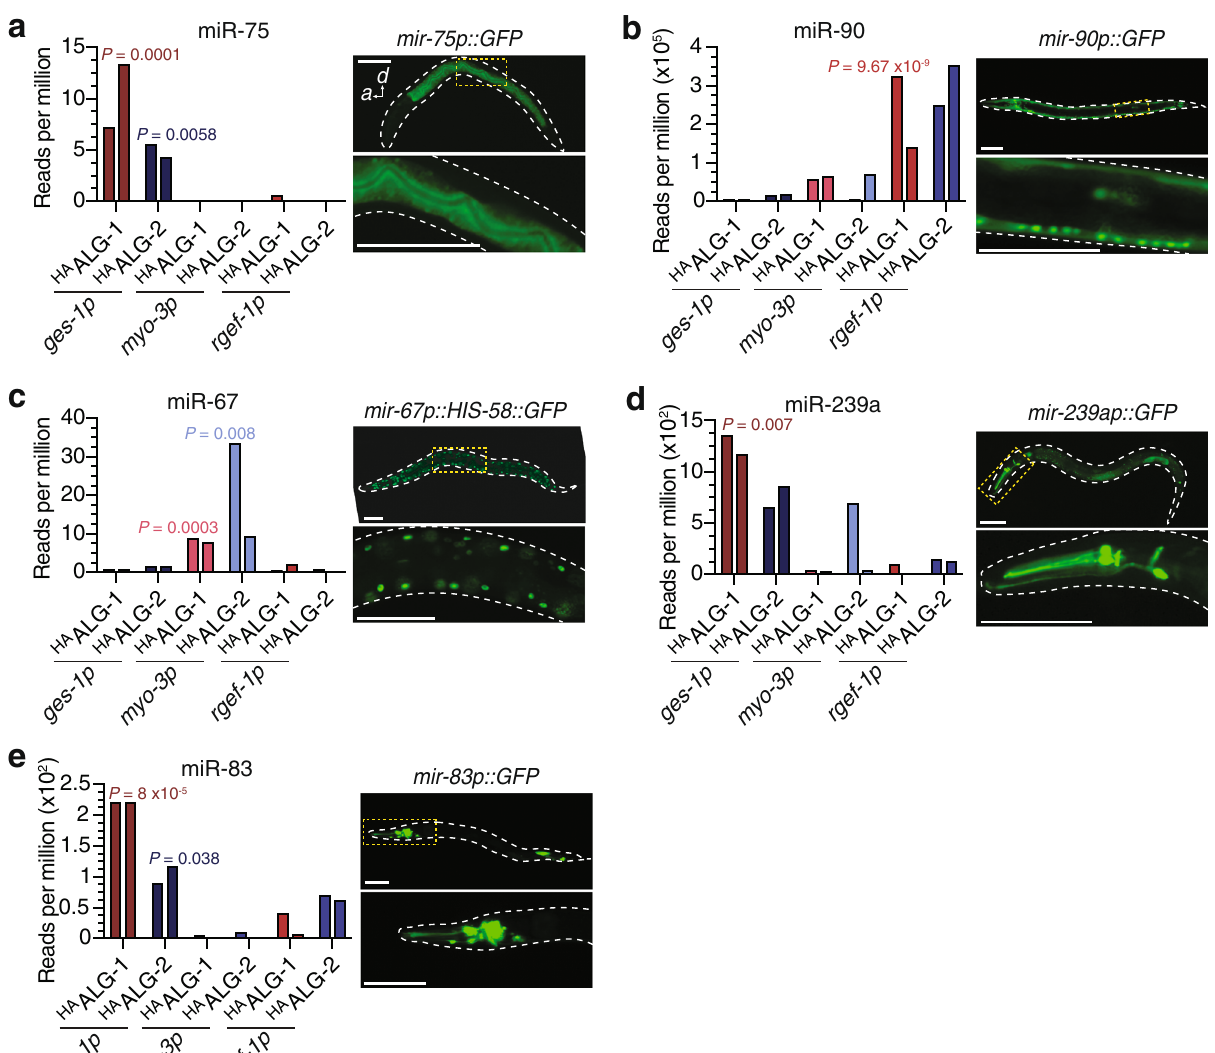
Fig. 4 Comparison of expression and cell-type-speci fi c loading of miRNAs. a Read counts per million in individual AGO- and cell-type-speci fi c libraries for miR-75 showing intestine enrichment. Live animal image (right) of the promoter of miR-75 fused to GFP, showing tight correlation of expression with loading pro fi le. b Cell-type-speci fi c read counts and promoter GFP fusion for neuron-enriched miR-90. c Cell-type-speci fi c read counts and promoter GFP fusion for muscle-speci fi c miR-67. d Intestine-speci fi c loading of miR-239a shown by read counts in individual cell-type libraries. Promoter expression of miR-239a showing enrichment of fl uorescence in neurons. e Intestine-enriched loading of miR-83 as compared to neuron-enriched expression. Graphs show reads per million in indicated cell types of two biological replicate experiments, two bars. Scale bars, 50 µ